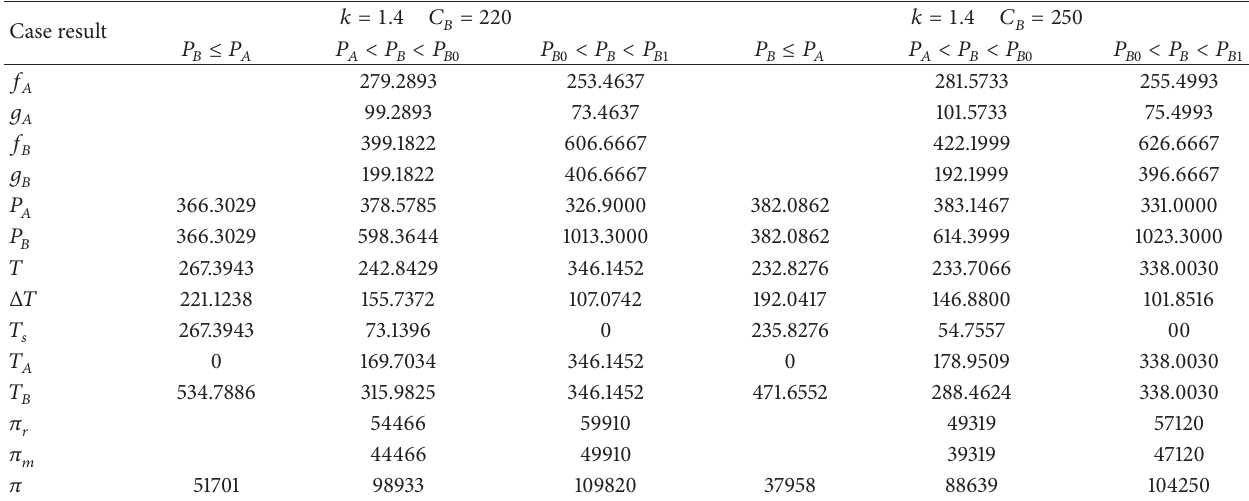
Table 3: The effect of RP cost changing in Stackelberg-Nash decision ( 𝑘 = 1.4